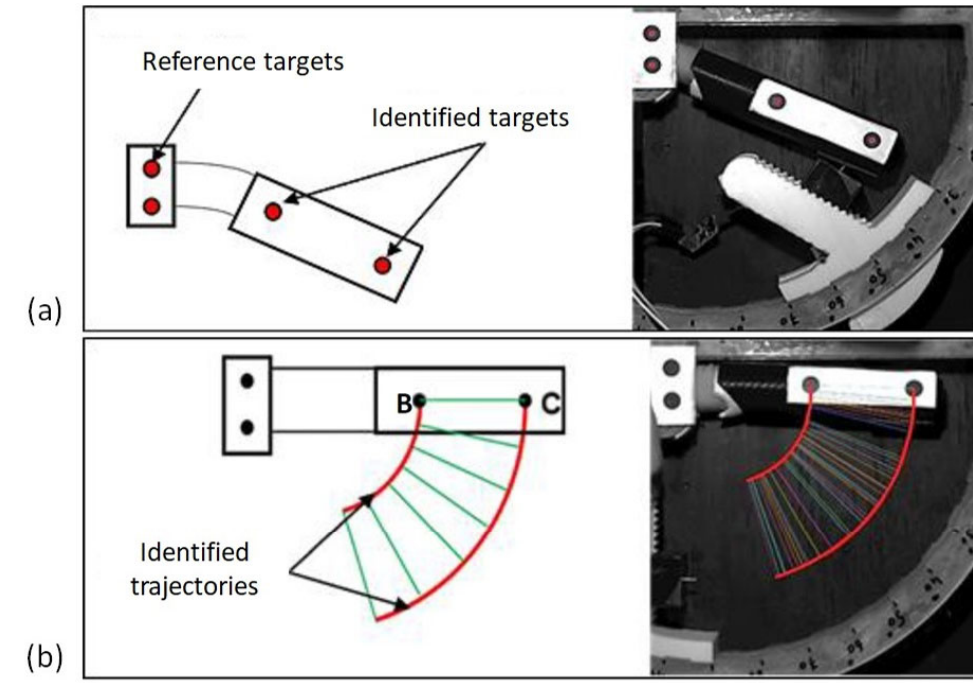
Figure 4. Optical instrumentation of the device with the use of circular targets. ( a ) Configuration of the device for measuring forces, ( b ) configuration without sensor for determining the centre of rotation of the joint.